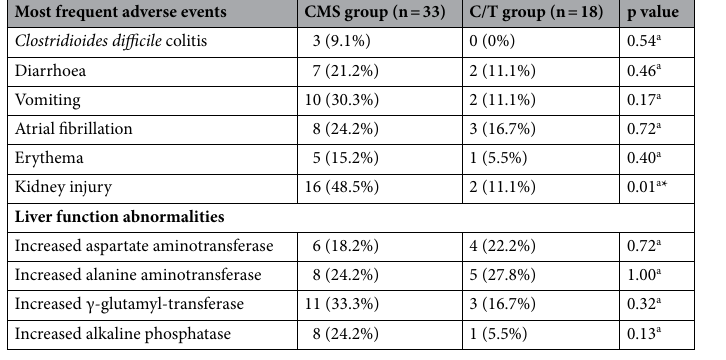
Table 4. Adverse events in colistin and ceftolozane/tazobactam treated patient groups. Data are expressed as absolute numbers (percentage). CMS colistimethate sodium; C/T ceftolozane/tazobactam. a χ 2 test or Fisher’s exact test. *p <